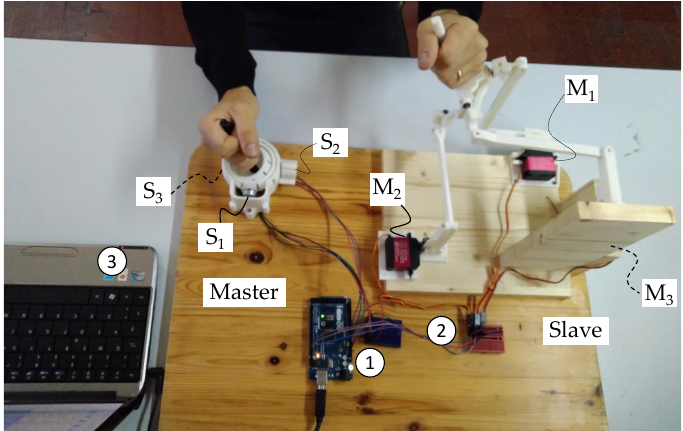
Figure 18. Top view of the proposed test bed of the mechatronic